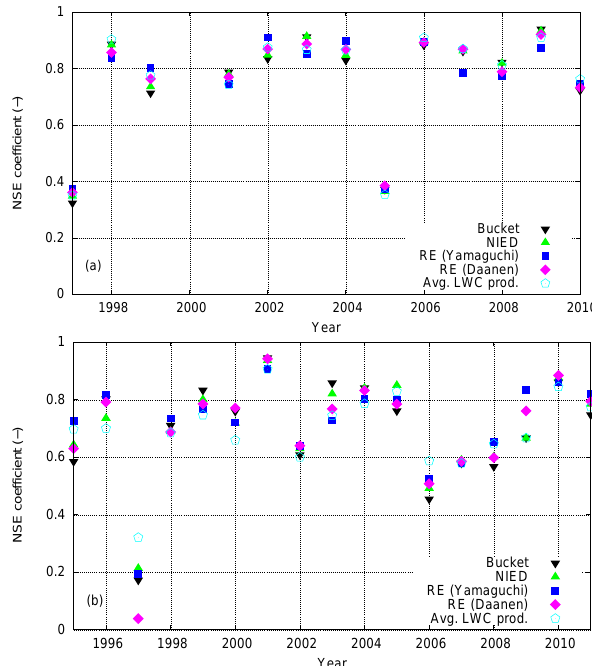
Fig. 3. NSE coefficients (model vs. measured) for the snow seasons for the 24h time scale for WFJ (a) and CDP (b) . The NSE coeffi- cients for snow season 2000 for WFJ are negative and not